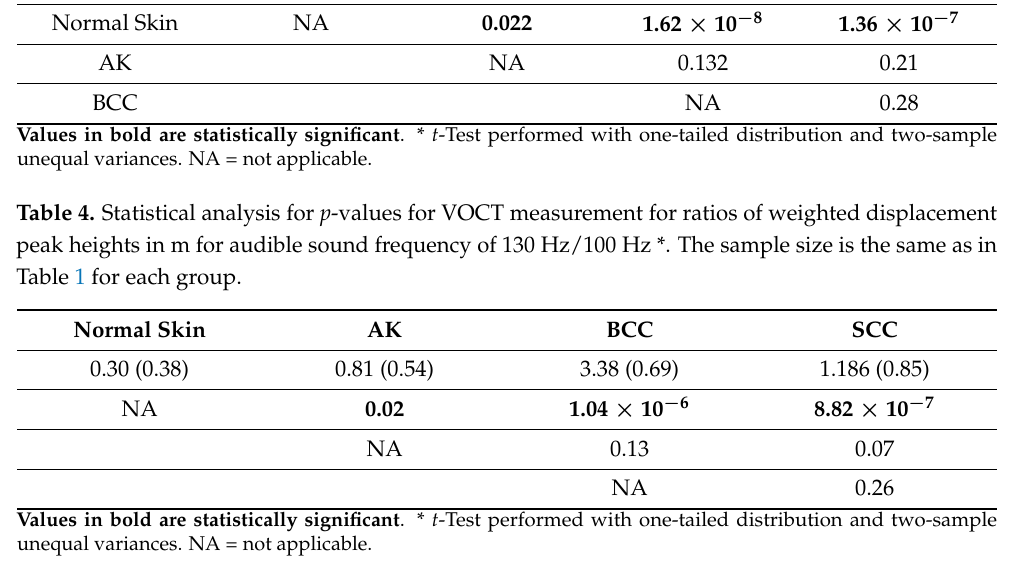
Table 5. Statistical analysis for p -values for VOCT measurement for weighted displacement peak heights in m for audible sound frequency of 260 Hz/100 Hz *. The sample size is the same as in Table 1 for each